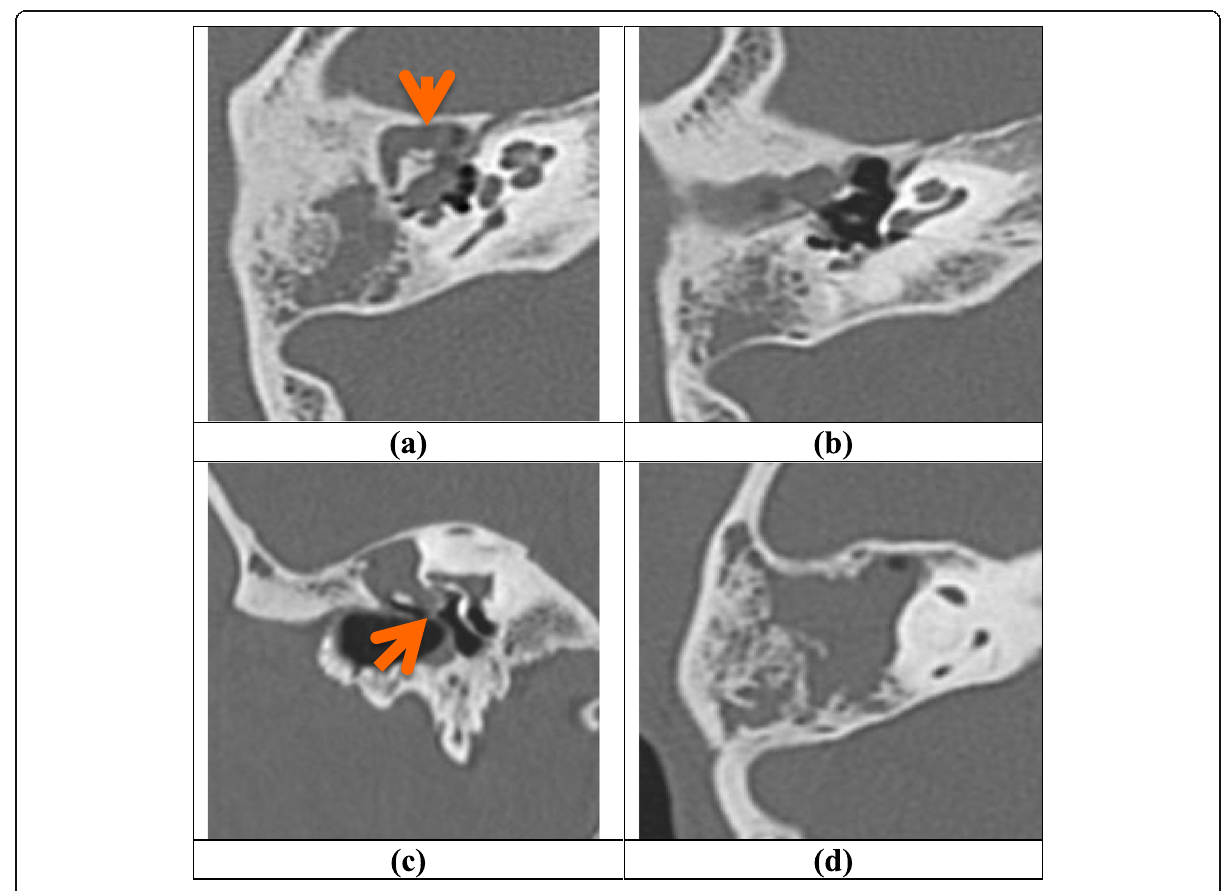
Fig. 7 Case 4: A 22-year-old male: Type-III in cholesteatomatous CSOM . Non-visualized bony projection at any level and this is termed as “ Absent. ” a – c Revealed ossicular erosions of the incus and malleus (arrowheads). d Revealed marked mass effect with marked attic walls scalloping and marked aditus widening. Also, an element of “ coalescent mastoiditis ” is seen, so the Köerner ’ s septum cannot be